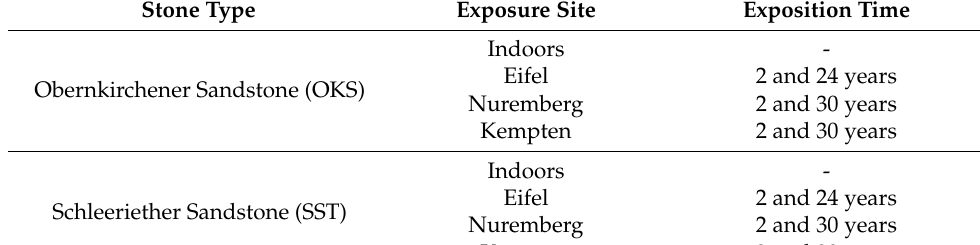
Table 2. Used stone types and their exposition.